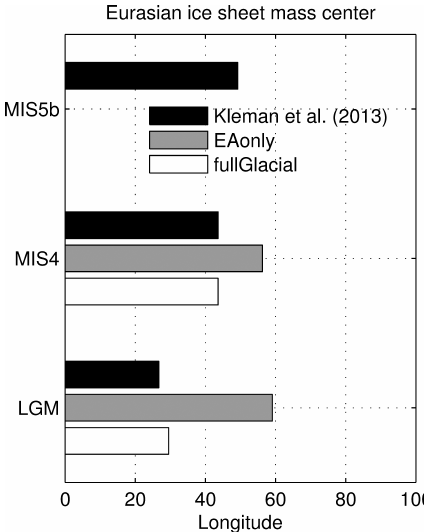
Figure 8. The longitude of the center of mass of the total ice dis- tribution in Eurasia ( λ c ) in the Kleman et al. (2013) reconstructions (black bars), EAonly simulations (gray bars), and fullGlacial simu- lations (white